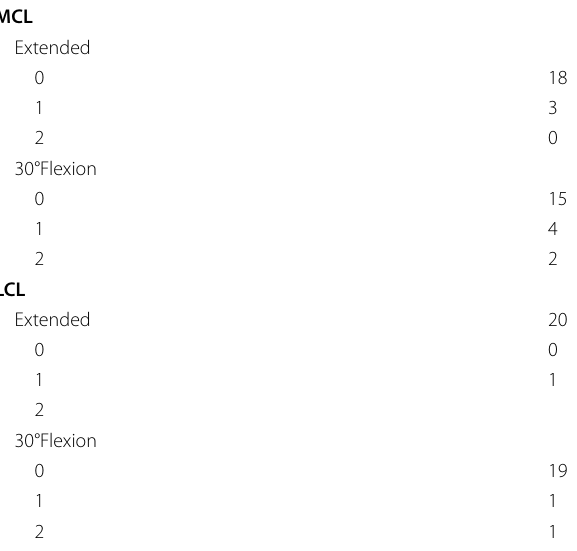
Table 5 The lateral and medial laxity at follow-up MCL